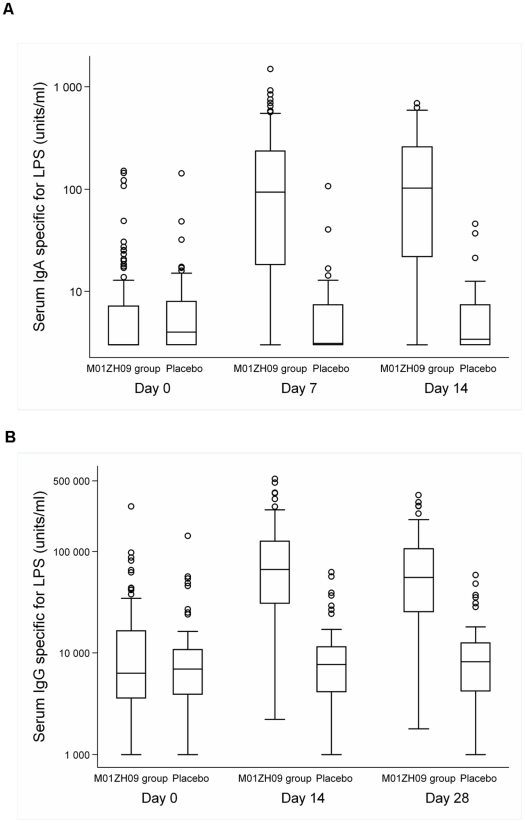
Time course of LPS specific serum IgA (A) and IgG (B) antibody levels according to vaccination groups (Intention to Treat population).Box and whisker plots showing the distribution of antibodies according to time point and vaccination groups. The horizontal line within each box represents the median, the top and bottom of each box represents the 75th and 25th percentiles, respectively, and the Ibar represents the highest and lowest values within 1.5 times the interquartile range. Circles show outliers.